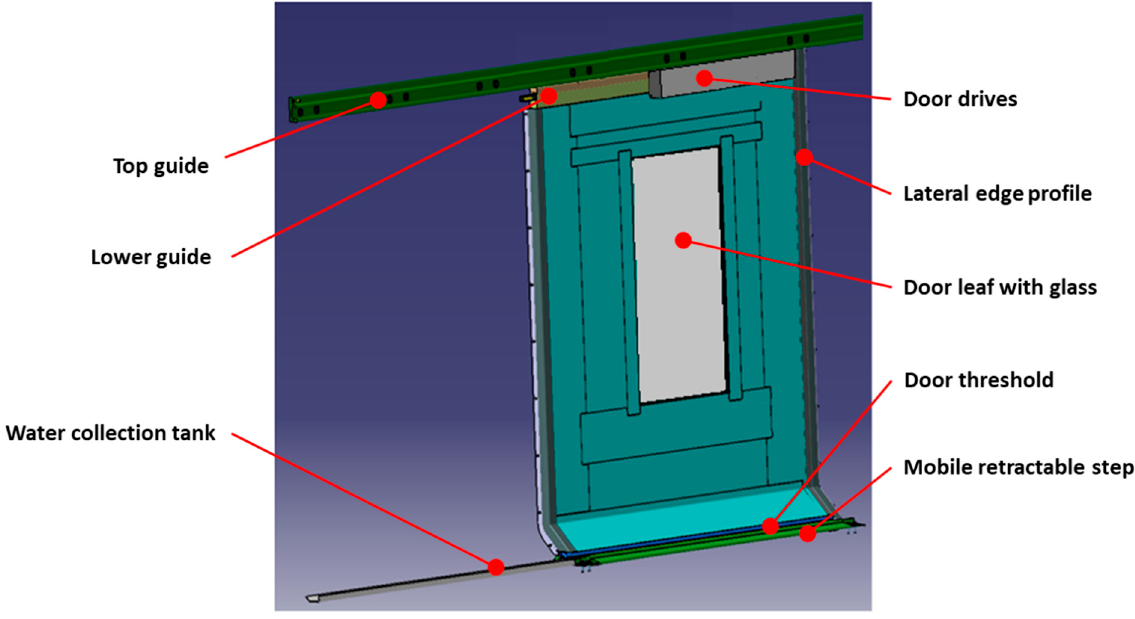
Figure 3. Train access door.